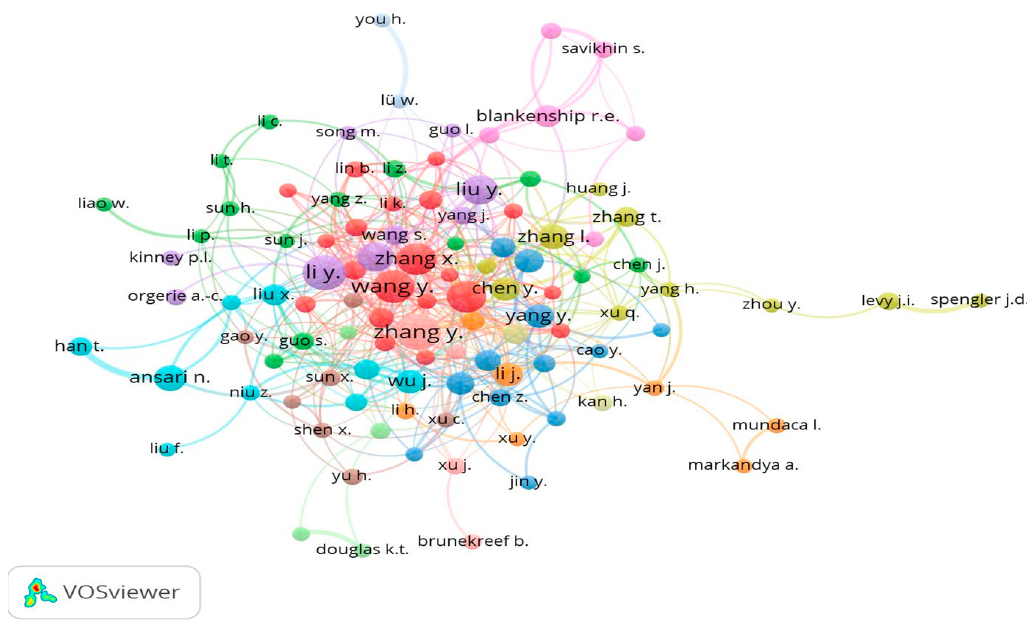
Figure 3. Visualisation of the bibliometric analysis of the papers on green electricity production technology according to the co-citation filter (source: developed by the author based on Scopus and VOSviewer).